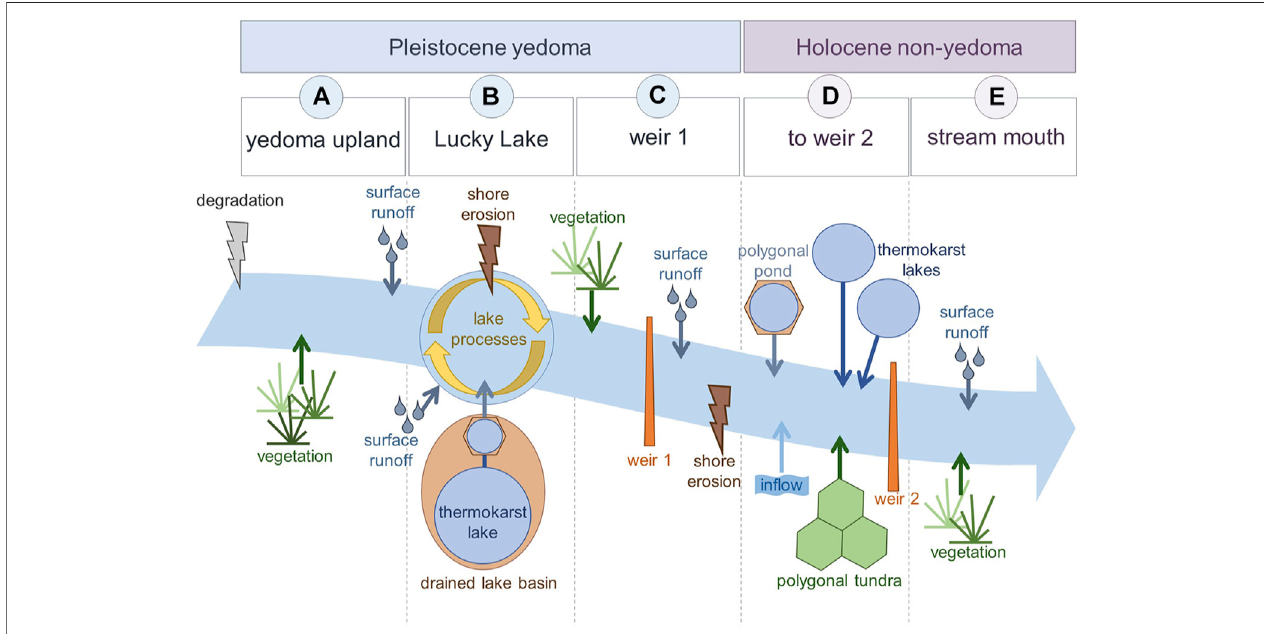
FIGURE6| Topviewschemeofthe fl owpathwith (A) yedomathawstreamashydrologicalstartofthe fl owpath, draininginto (B) theLuckyLake,draininginto (C) the Lucky Lake stream on Pleistocene yedoma to weir 1, and further on (D) Holocene non-yedoma to weir 2, and fi nally to (E) the stream mouth to the Olenyokskaya Channel. Arrows symbolize the input of OC from different sources. Whereas input from surface runoff and vegetation occurs at each sampling point, input from degradation of the yedoma upland, lake shore and stream bank erosion, in fl ows, thermokarst lakes, polygonal ponds, and polygonal tundra occur selectively.